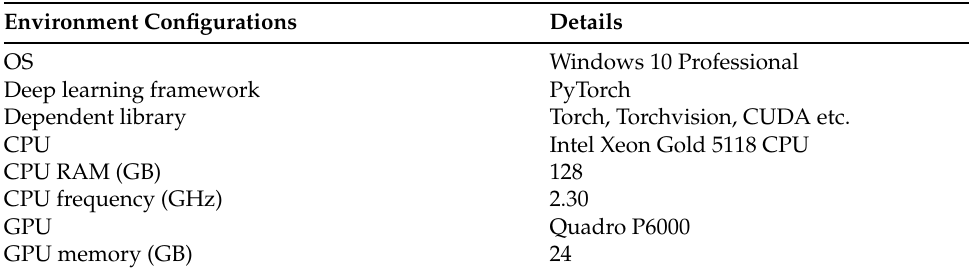
Table 3. Environment